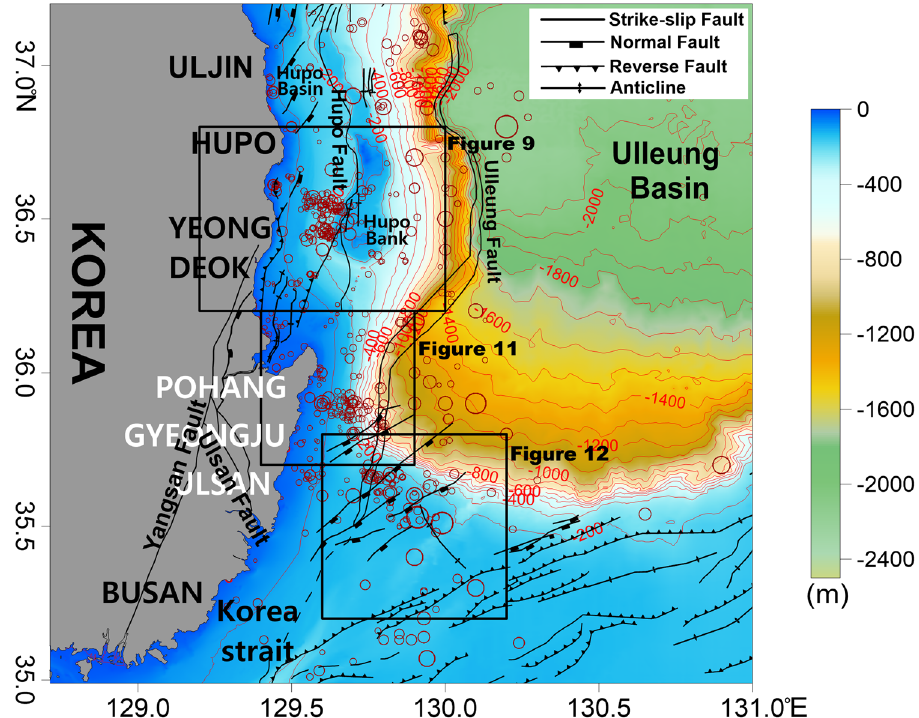
Figure 2. Bathymetry map of the study area with major geologic structures and earthquake locations. Bathymetric contours are shown in meters. Structural data were compiled from the reports of Yoon et al. 14 and Son et al. 15 . The black boxes represent the map areas in Figs. 9, 11, and 12. The red circles represent the locations of earthquakes. The size of a circle is proportional to the magnitude of an earthquake, from 0.7 to 5.2. This figure was generated using the Surfer software (https:// www. golde nsoft ware.